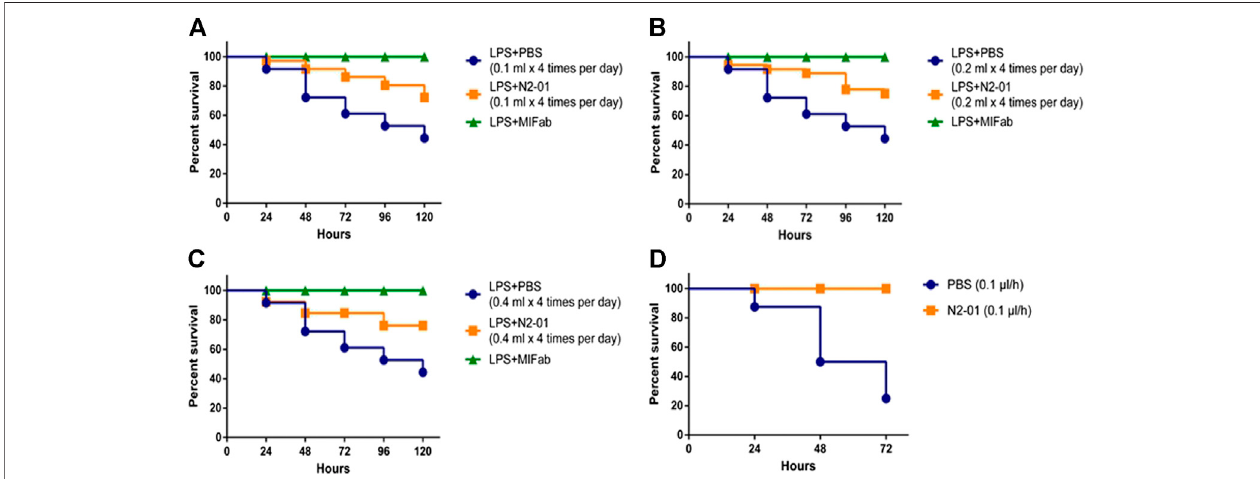
FIGURE3| EffectsofN2-01treatmentonLPS/GalN-inducedlethality. (A) 0.1 mlN2-01(4timeperday), (B) 0.2 mlN2-01(4timeperday), (C) 0.4 mlN2-01(4time per day), (D) 1.0 μ L/h N2-01 was infused with Alzet osmotic pumps. Group survival was compared using a Logrank test Logrank test for trend.